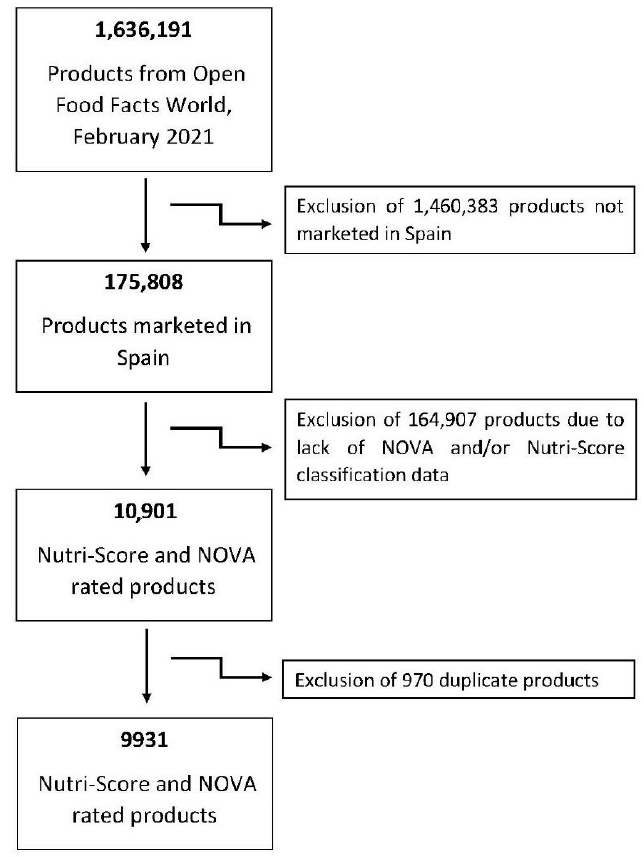
Figure 1. Flowchart of the total amount of foods included in the study.